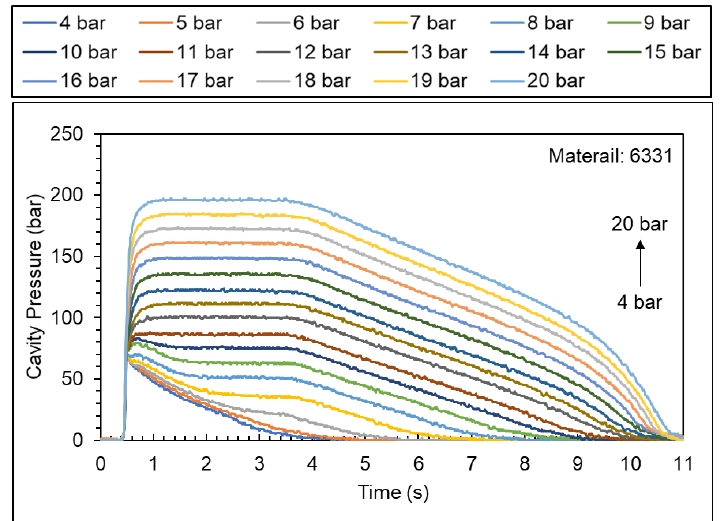
Figure A2. Cavity pressure profiles of 6331 at different packing pressures.